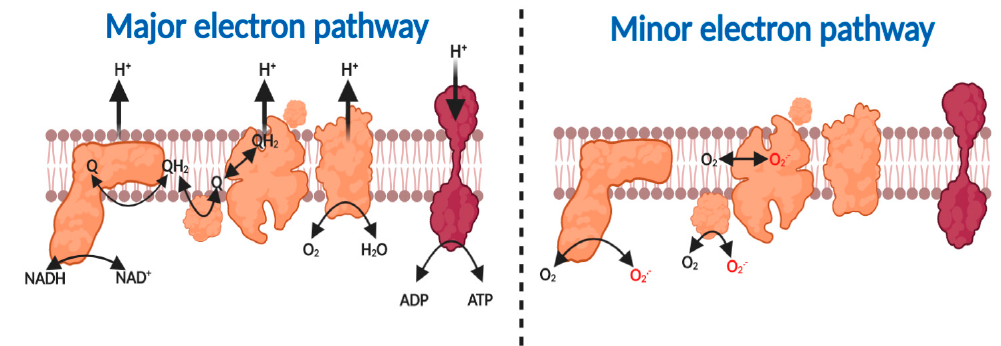
Figure 1. Major and minor electron pathways in the mitochondrial respiratory chain. Major pathway ( left to right ). Complex I oxidizes NADH to NAD + to reduce ubiquinone (Q) to ubiquinol (QH 2 ). Complex II oxidizes succinate to fumarate to produce QH 2 . Complex III oxidizes QH 2 to reduce cytochrome c. Reduced cytochrome c is then oxidized by complex IV to reduce O 2 to H 2 O. The proton motive force generated by complex I, III and IV is harnessed by Complex V to synthesize ATP. Minor pathway left to right. Substrate-derived electrons can reduce O 2 to O 2 •− at complex I, II and III.